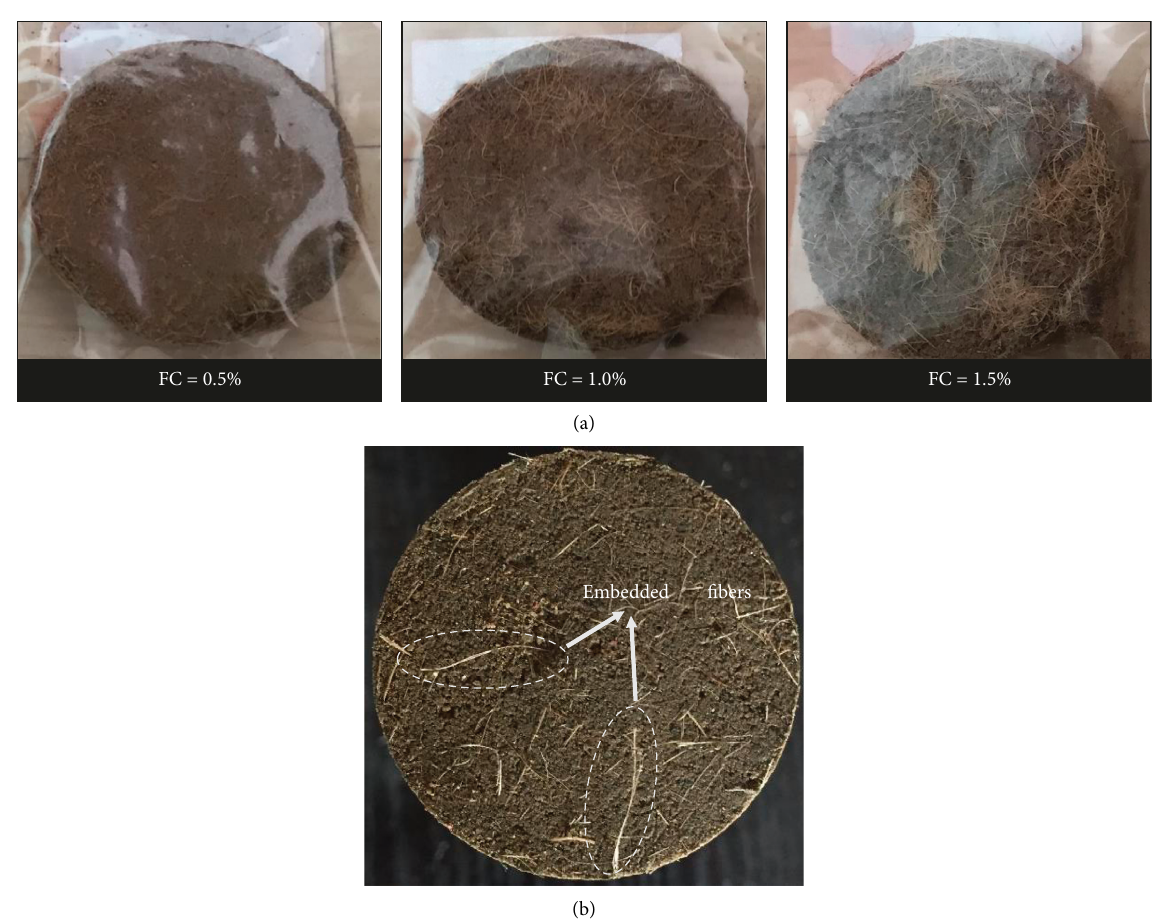
Figure 2: Appearance of test blocks. (a) Three test blocks with different fiber contents. (b) Surface micromorphology of the test block. SEM